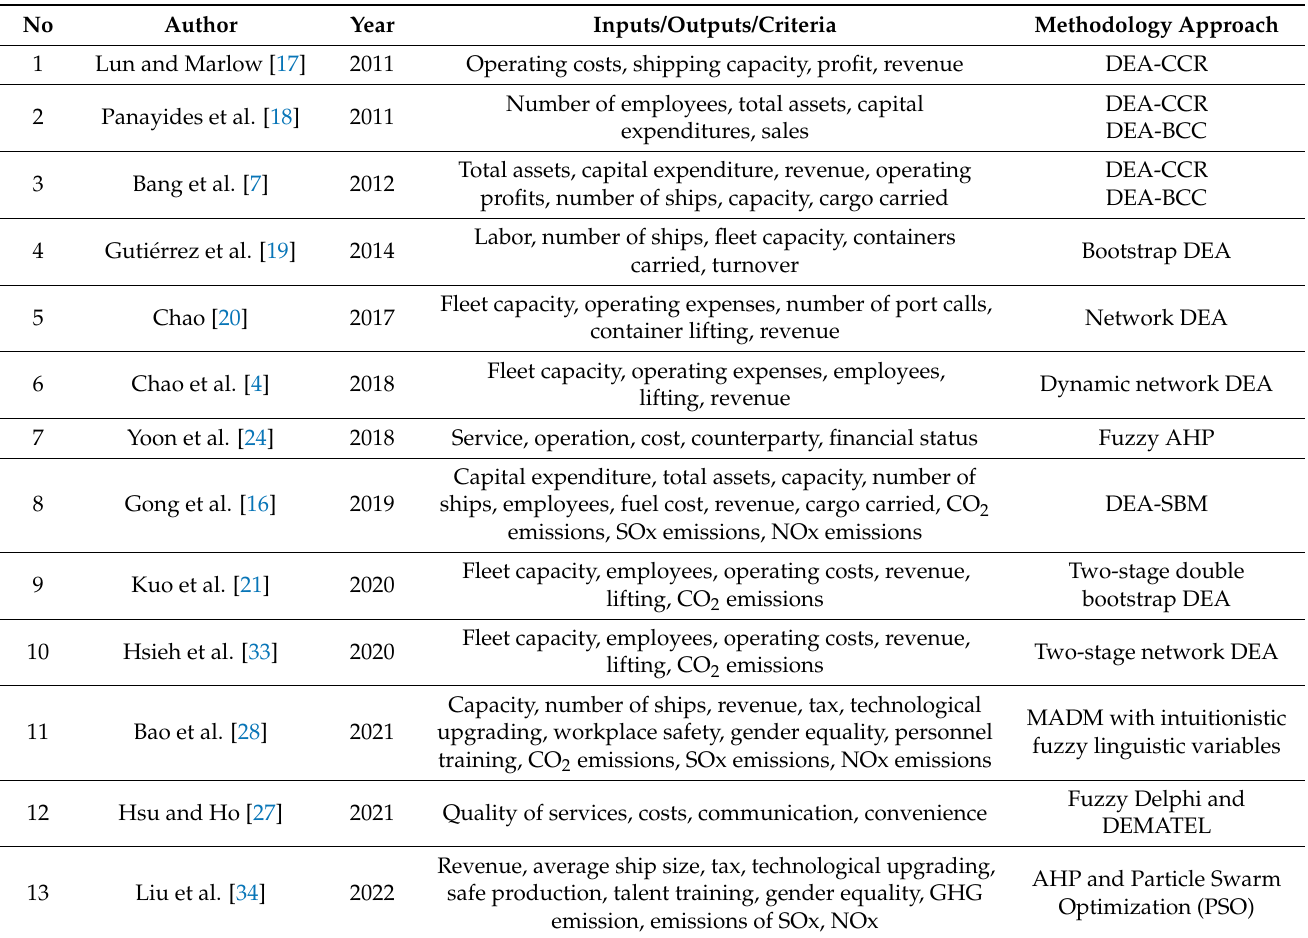
Table 1. Overview of studies on CSCs’ efficiency